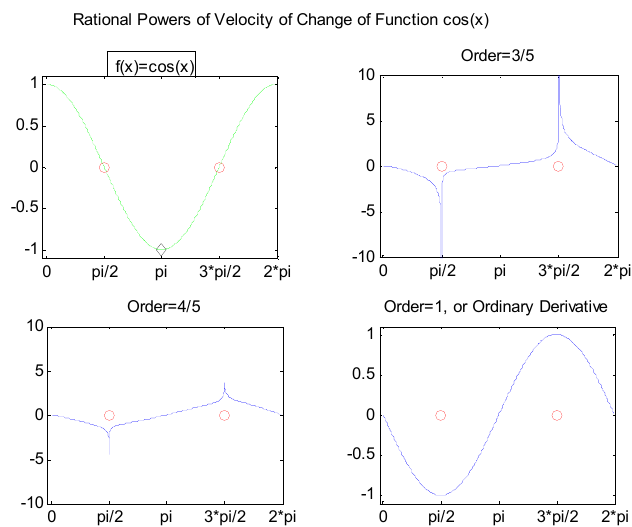
Figure 5. The rational orders of rates of change for the cosine function (Orders are 3/5, 4/5, 1).